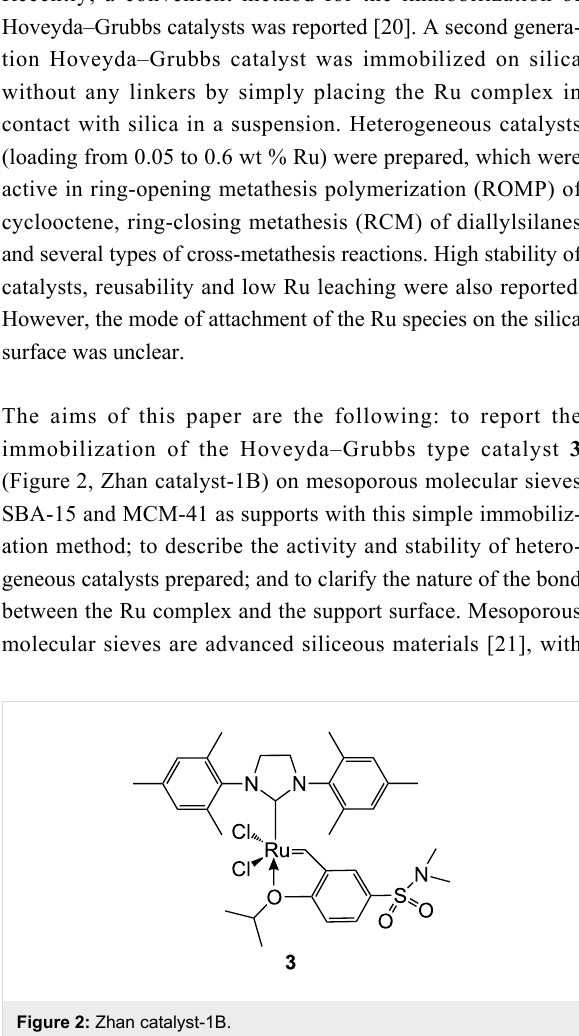
Figure 1: Grubbs 1 and Hoveyda–Grubbs 2 catalysts.